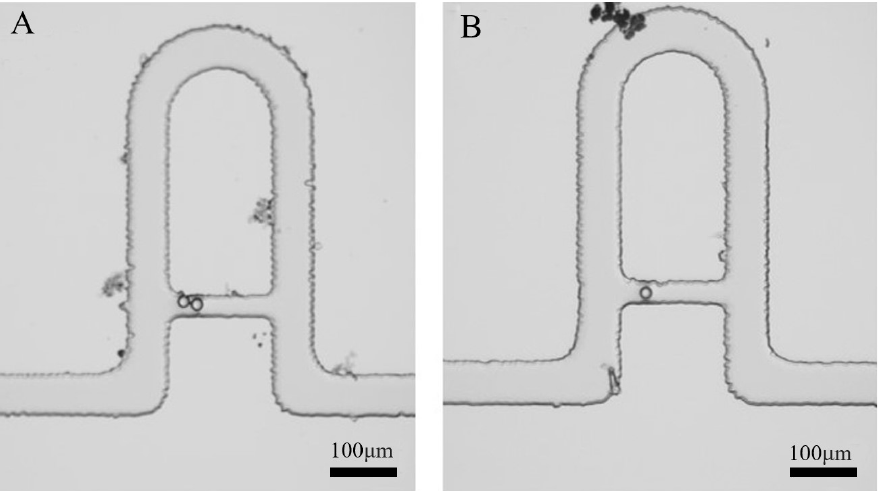
Figure 4. Micrographs of 20–25μm Polystyrene Microbeads trapped in cavities. ( A ) One microbead trapped in a capturing cavity ( B ) two microbeads tapped in a capturing cavity.